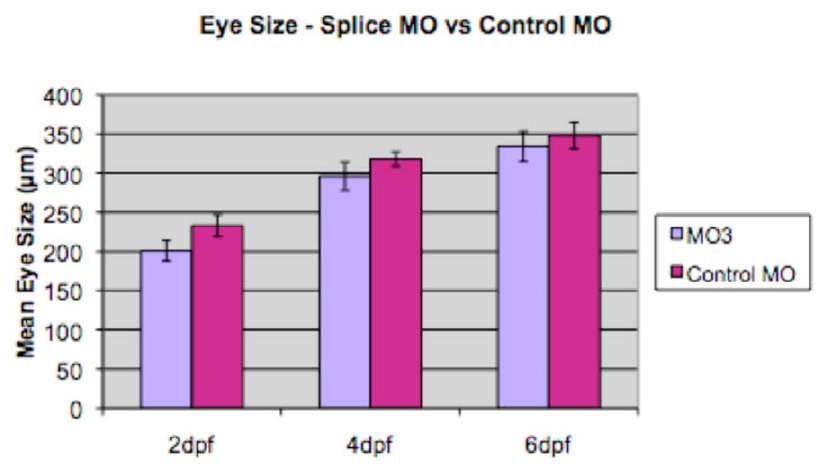
Figure 6. A comparison of eye size in splice morpholino-injected larvae and control-injected larvae. Graph shows mean eye size (measured in m m on y-axis) for splice morpholino-injected larvae (MO3; light purple) compared to control-injected larvae (Control MO; dark purple) at three different time periods, 2 dpf, 4 dpf and 6 dpf, labeled on the x-axis. Data are shown as mean + / 2 one standard deviation. A representative single experiment is shown, measuring a minimum of 10–20 independent retinas per data point. Analysis using a Two-sample t-test assuming equal variance showed a significant difference at 2 dpf and 4 dpf (p , 0.05 for 2 dpf), but not at 6 dpf (p . 0.05).